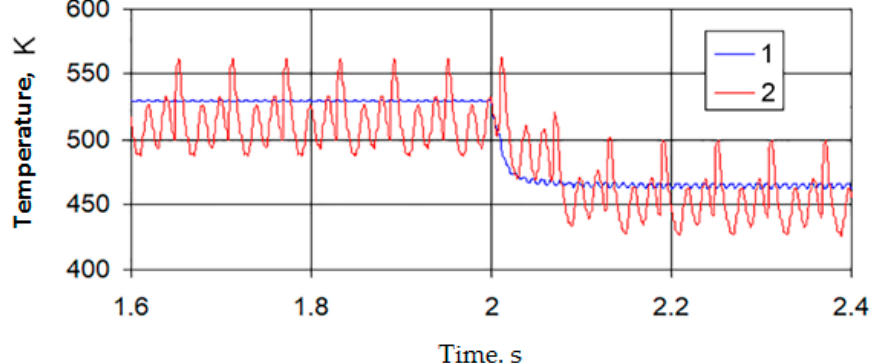
Figure 7. Dynamics of the change in the temperature of gases at the installation site of the injectors (1) and in the inlet channel of the cylinder head (2). (Source: Authors).